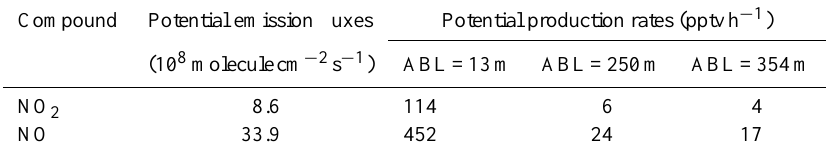
Table 3. Potential depth integrated NO x emission fluxes and equivalent NO x production rates from NO − of 30cm, a solar elevation angle of 23 ◦ and three different atmospheric boundary layer heights (ABL) from previous measurements (Frey et al.,